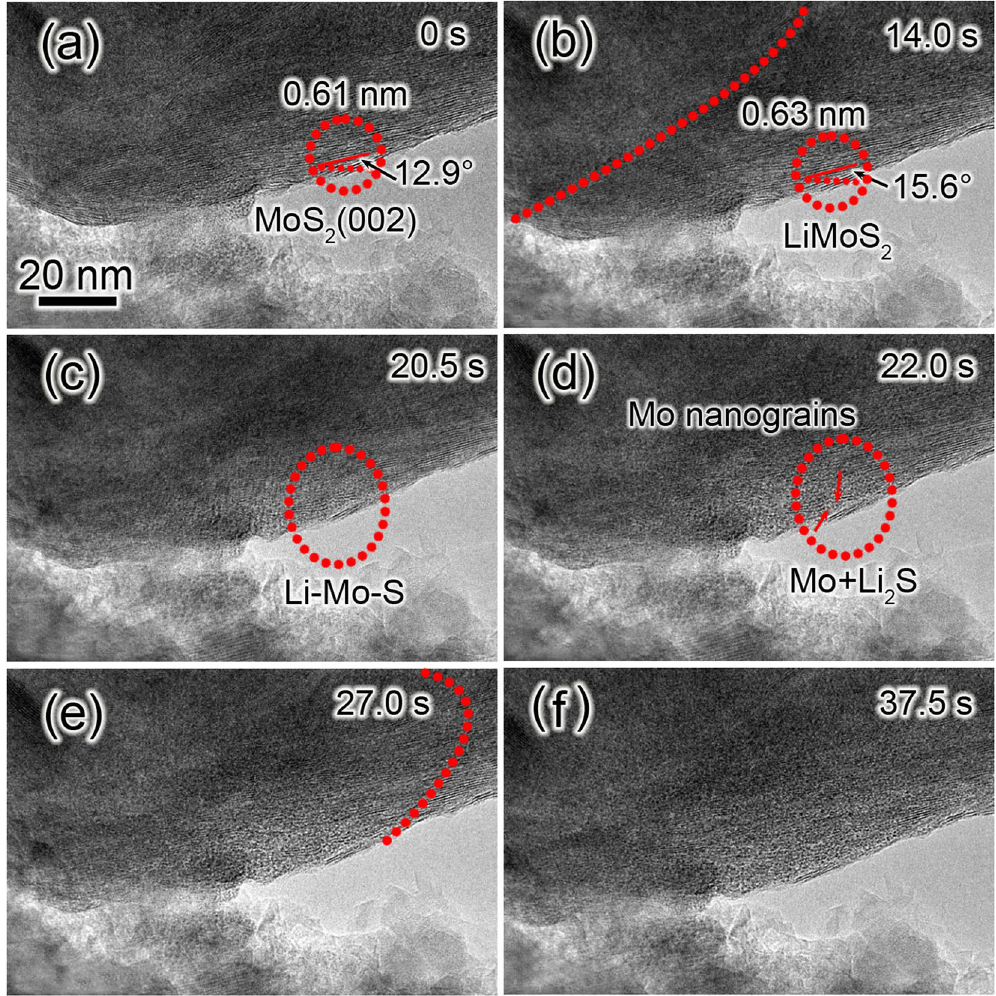
Figure 2. In situ TEM study on the lithiation of an individual MoS 2 nanosheet. ( a – f ) Time-resolved TEM images of the first lithiation process. All the scale bars are 10